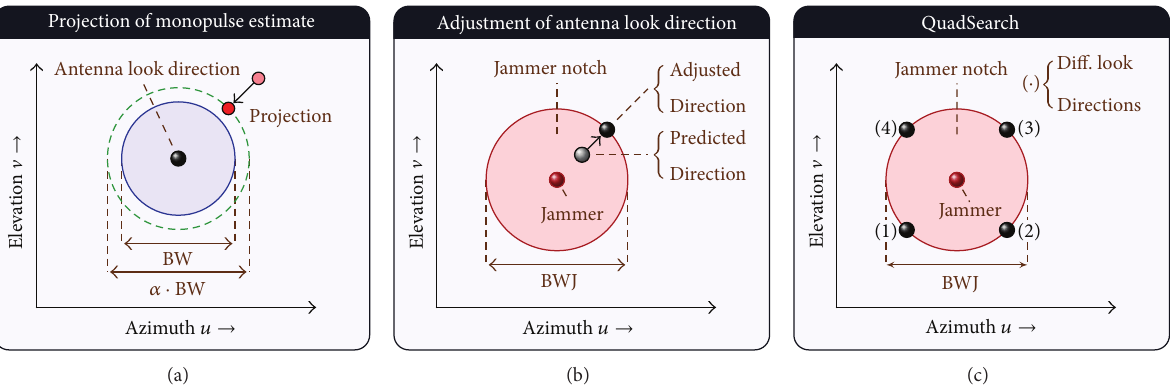
Figure 18: Illustration of different stabilization measures to improve track stability and track continuity.